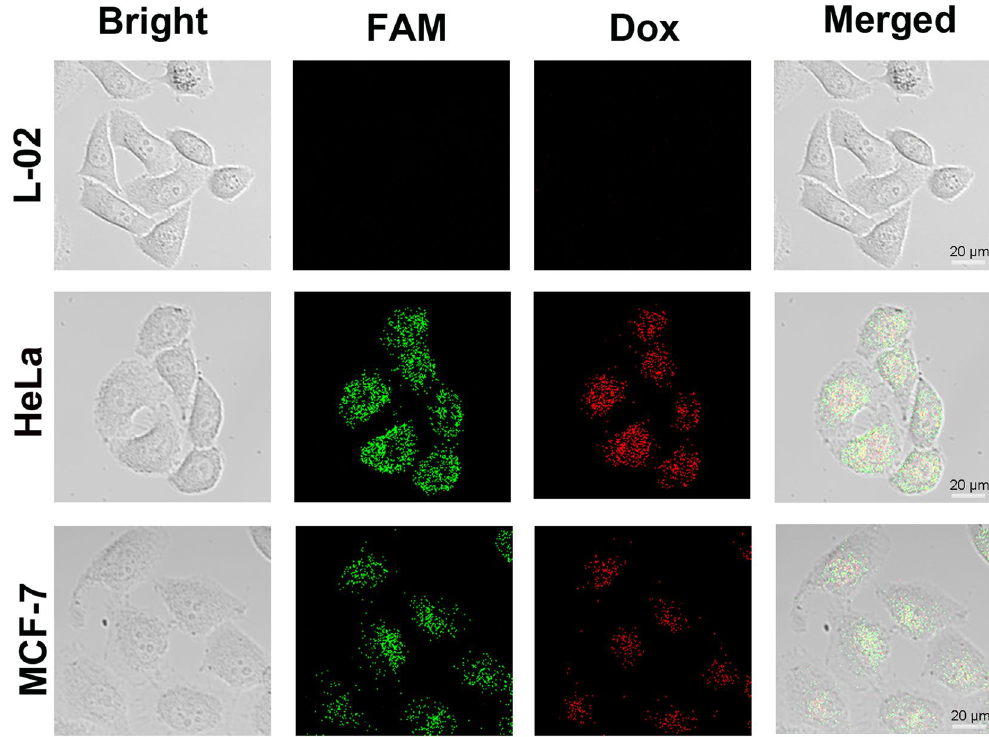
Figure 6. The evaluation of DNA conformational switch-based Dox-AuNP-MPs for telomerase activity monitoring and Dox delivery in individual cells: HeLa, MCF-7 and L-02